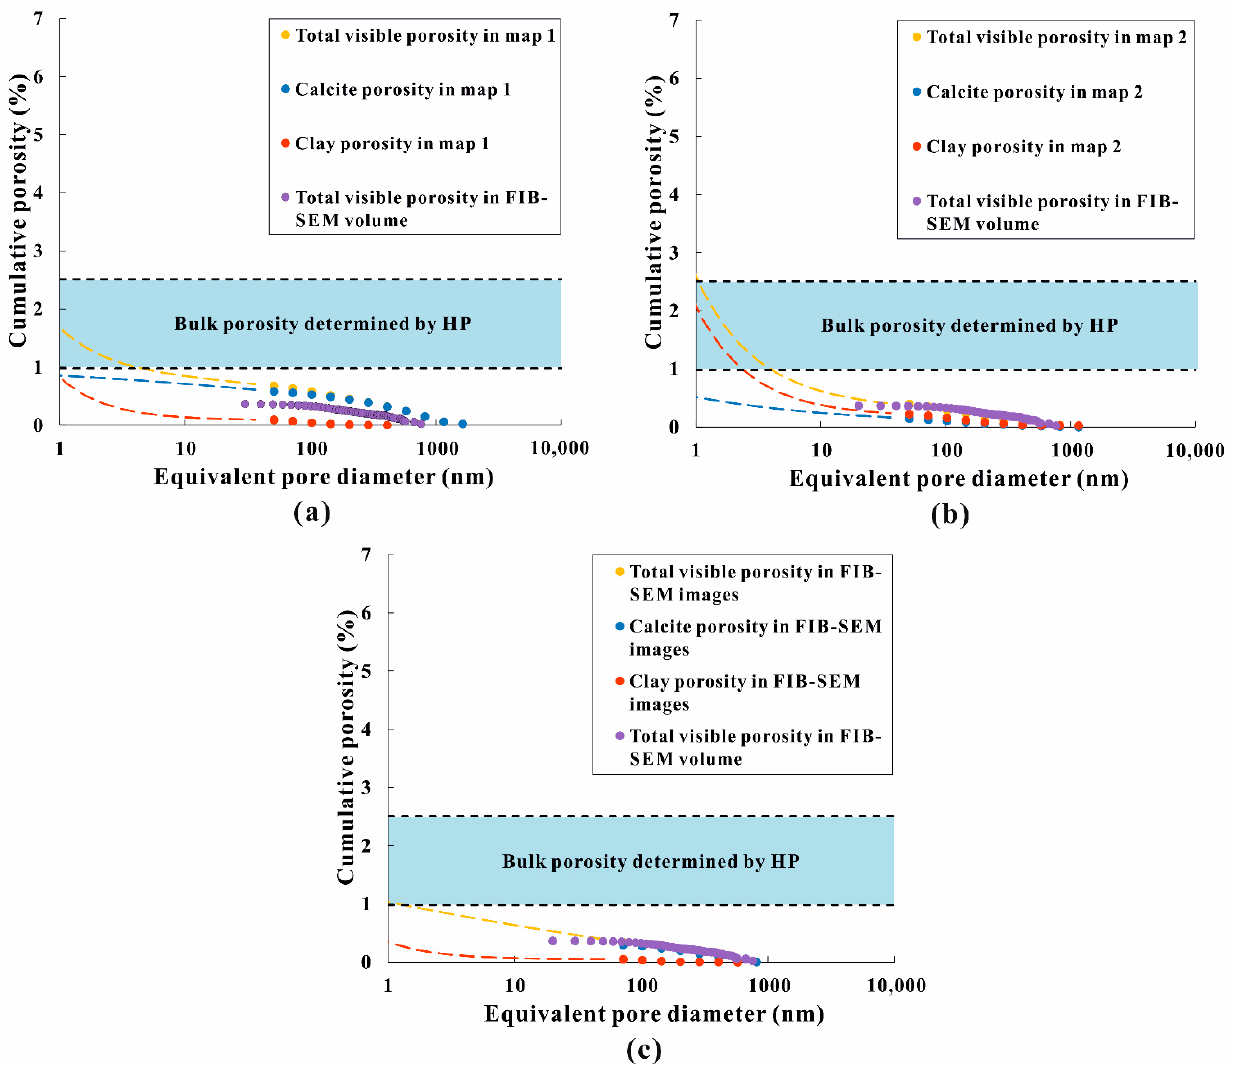
Figure 13. Extrapolation of cumulative porosity distributions obtained from BIB-SEM map 1 ( a ), map 2 ( b ), and FIB-SEM images ( c ). Cumulative porosity distribution obtained from FIB-SEM volume (purple data point) and HP bulk porosities (blue zone) from Hu et al. [17] are compared. D and log C values are utilized for the extrapolations of cumulative calcite and clay porosities, which are represented by the blue and red dashed lines, respectively. The extrapolation of cumulative total porosity in map 1 and 2 is the sum of extrapolated cumulative calcite and clay porosities and is represented by the yellow dashed line. As no linear relationship exists in the normalized pore size distribution of calcite phase in 2D FIB-SEM images, D and log C are utilized for the extrapolation of cumulative total porosity and clay porosities in FIB-SEM images. All the porosities here are absolute